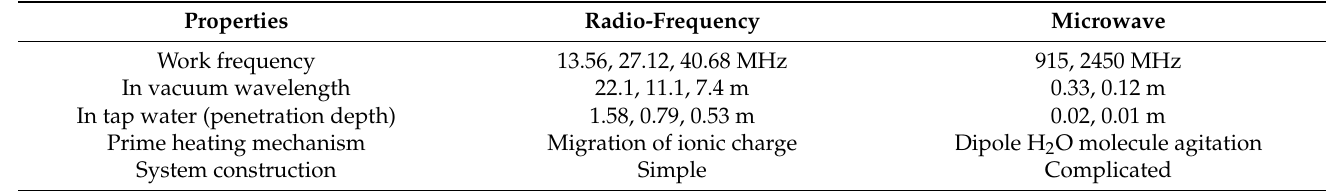
Table 2. Differentiation of major properties between radio frequency (RF) or microwave heating in the food industry